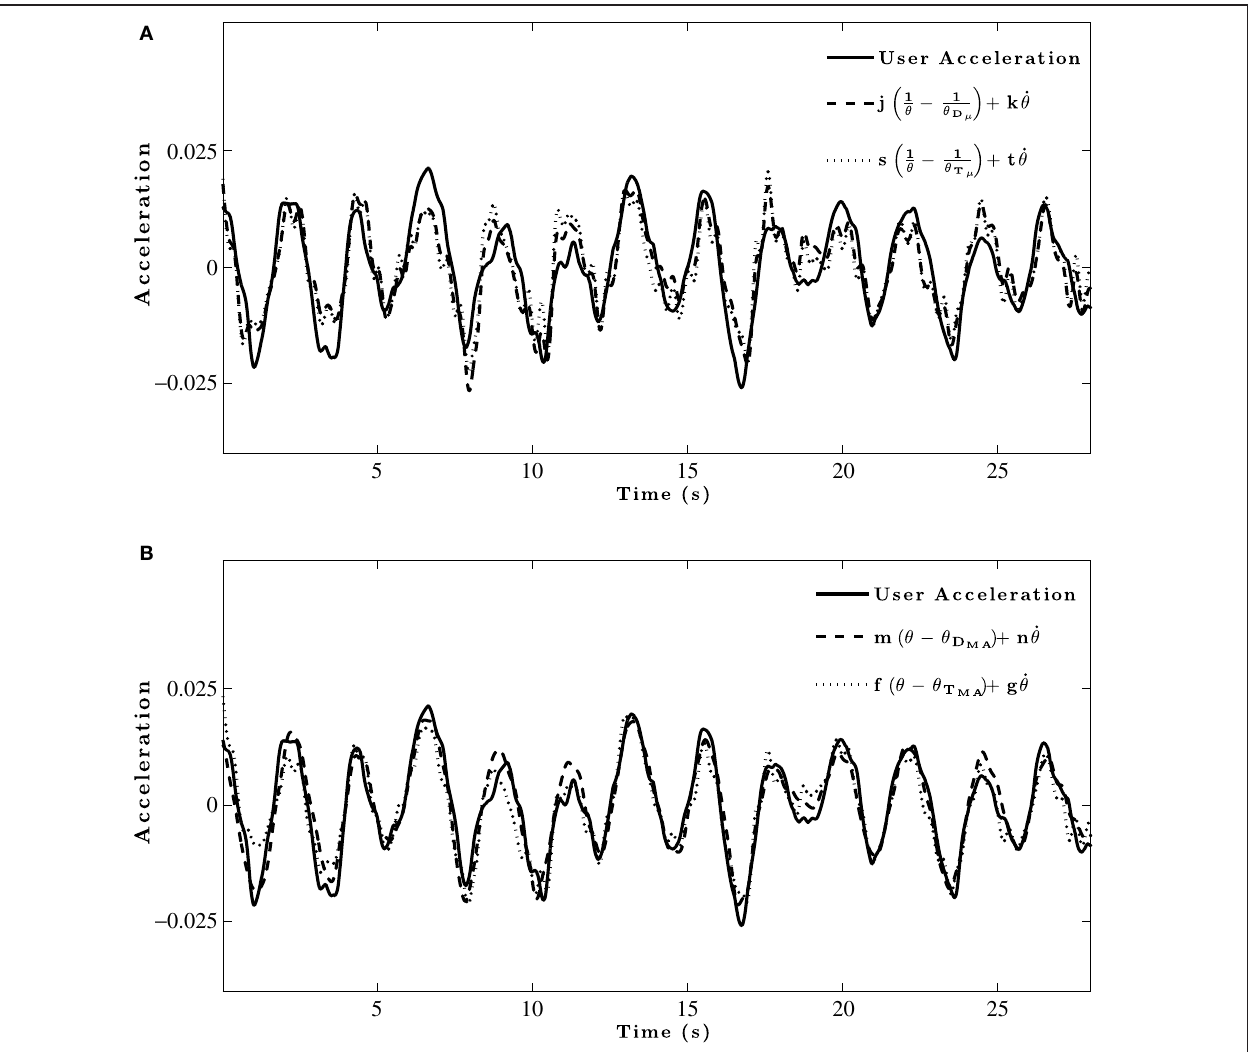
FIGURE 5 | Example model fit to group averaged acceleration data for a single trial. (A) Initial model fitting comparing θ D μ and θ T μ models. (B) Model fits and θ T for comparison of optimized θ D MA MA